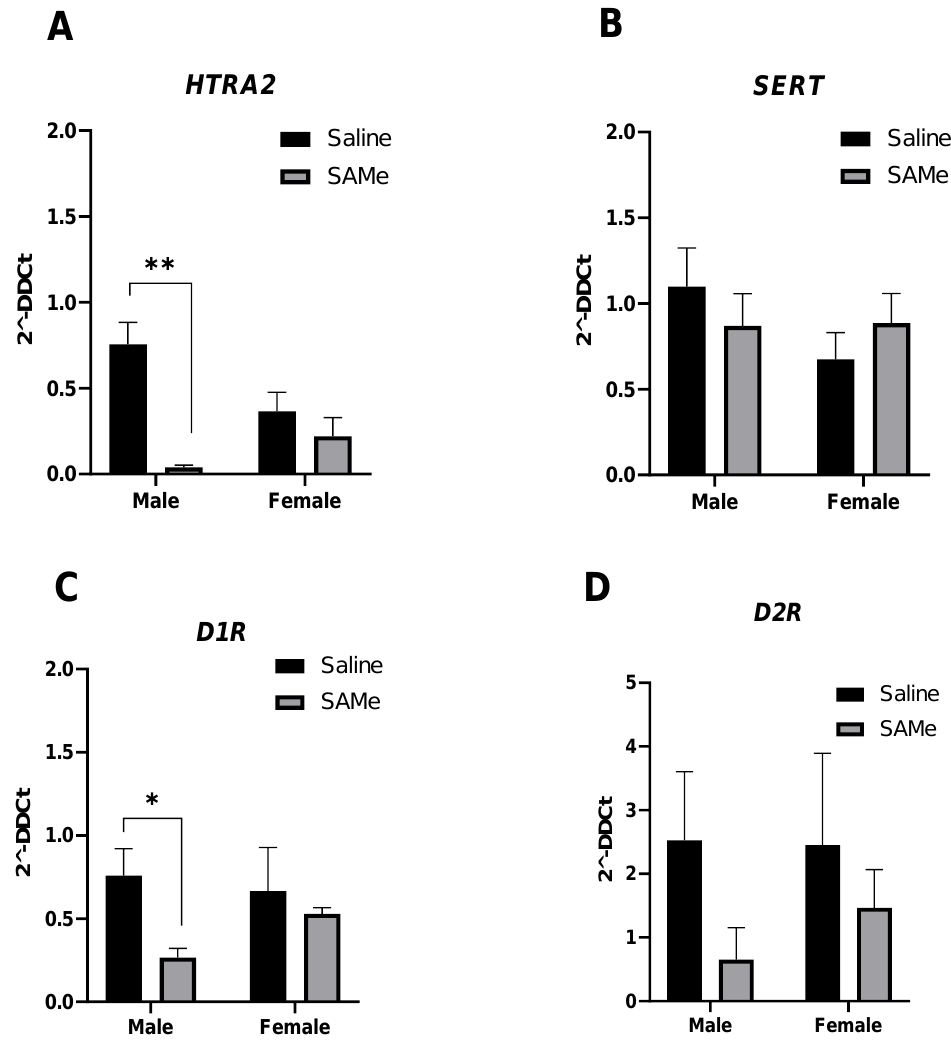
Figure 4. Htr2a, Sert, D 1 R and D 2 R genes expression. SAMe treatment significantly decreased the expression of Htr2a ( A ) and D 1 R ( C ) genes only in male Sub mice. No effect of SAMe treatment was measured on Sert ( B ) and D 2 R ( D ) gene expression in either males or females. The data are presented as means ± SEM, * p < 0.05 or ** p < 0.002.